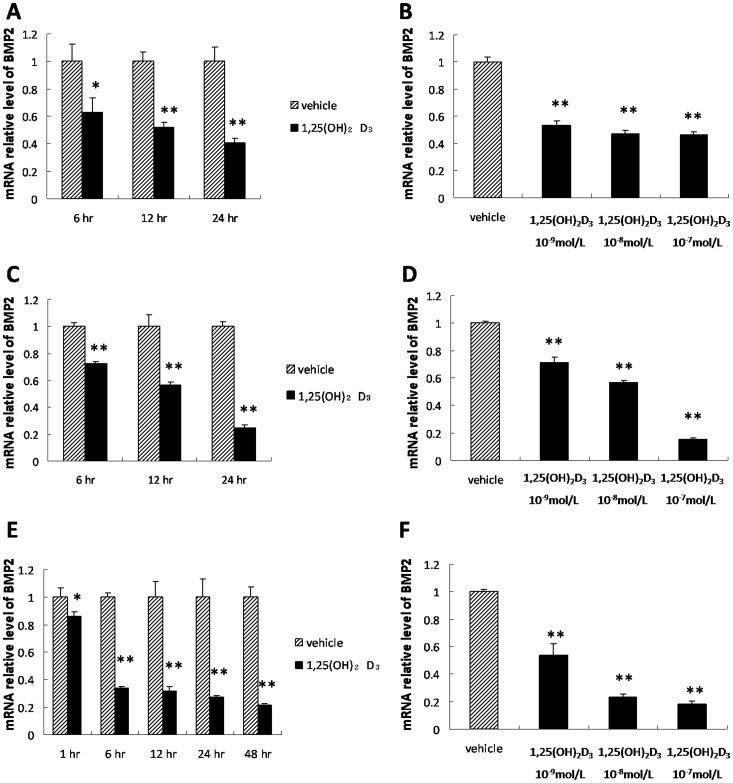
Repression of BMP2 by 1,25(OH)2D3.A. qRT-PCR of BMP2 expression in BMSCs from SD rats at several time points treated with 10−8 mol/L 1,25(OH)2D3. B. qRT-PCR of BMP2 expression in BMSCs from SD rats treated with a range of concentrations of 1,25(OH)2D3. C. qRT-PCR of BMP2 expression in BMSCs from GHS rats treated with 10−8 mol/L 1,25(OH)2D3 at different points in time. D. qRT-PCR of BMP2 expression in BMSCs from GHS rats treated with step-wise concentrations of 1,25(OH)2D3. E. qRT-PCR of BMP2 expression in UMR-106 cells treated with 10−8 mol/L 1,25(OH)2D3 at multiple time points. F. qRT-PCR of BMP2 expression in UMR-106 cells treated with varying concentrations of 1,25(OH)2D3. (*, P<0.05; **, P<0.01).